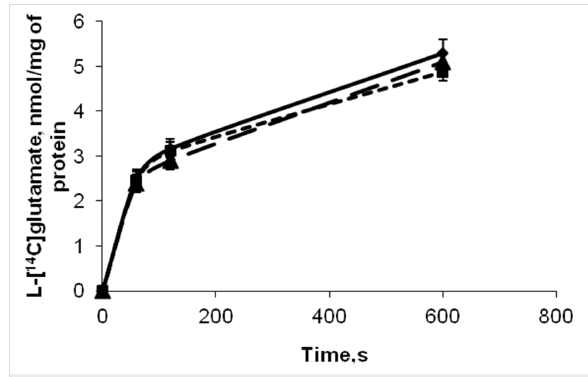
Figure 3: Time course of uptake of L-[ 14 C]glutamate by control synap- tosomes (solid line); synaptosomes in presence of uncoated γ -Fe 2 O 3 nanoparticles (dashed line) and D-mannose-coated γ -Fe 2 O 3 nanopar- ticles (dotted line). Uptake was initiated by the addition of L-[ 14 C]gluta- mate to synaptosomes, after incubation the samples were rapidly sedi- mented and radioactivity was determined as described in section Experimental. Data represent mean ± SEM of three independent